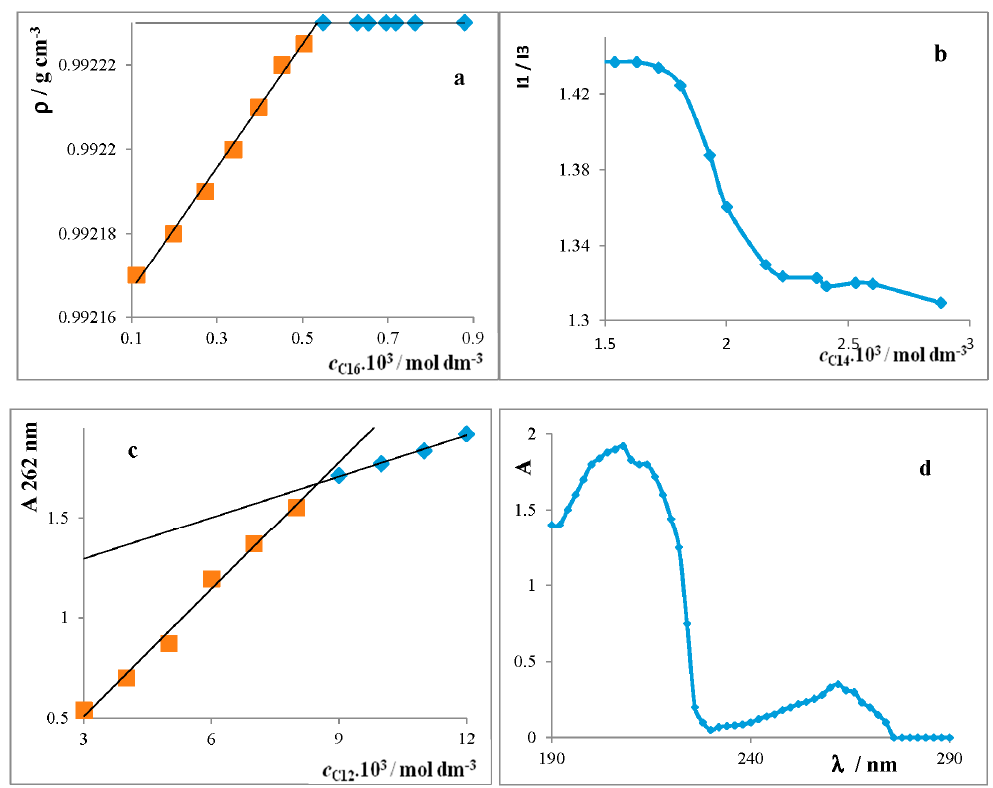
Figure 2. Dependence of ρ = f ( c C16 ): ( a ) ( t = 40 °C); I 1 /I 3 = f ( c C14 ); ( b ) ( t = 25 °C); A = f ( c C12 ); ( c ) ( t = 25 °C), and ( d ) absorption spectrum C12.